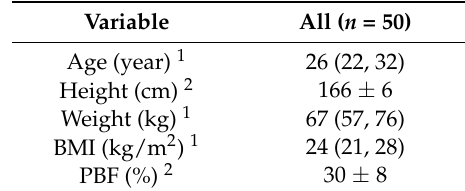
Table 2. Anthropometric characteristics of